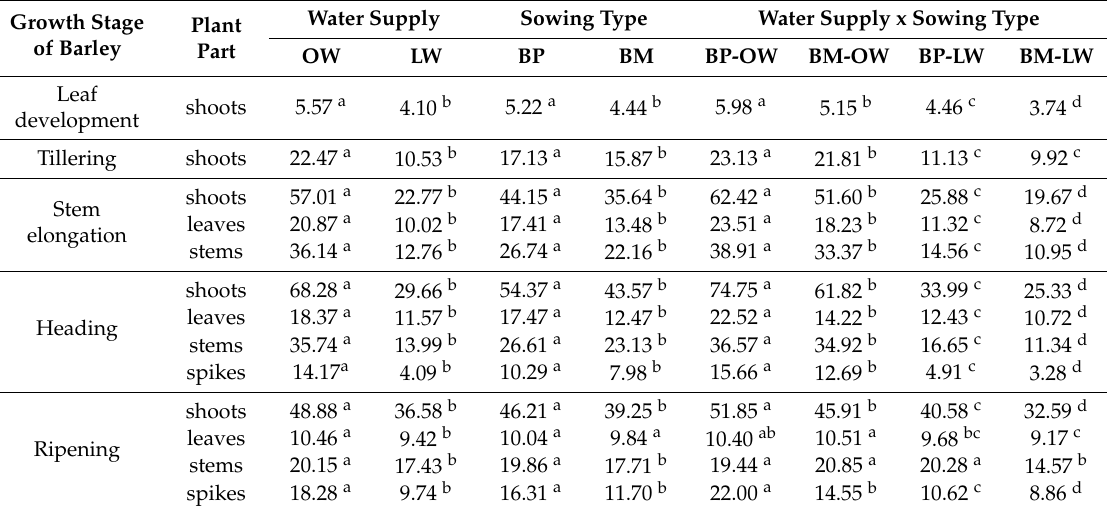
Table 1. Phosphorus accumulation by barley (mg pot − 1 ).